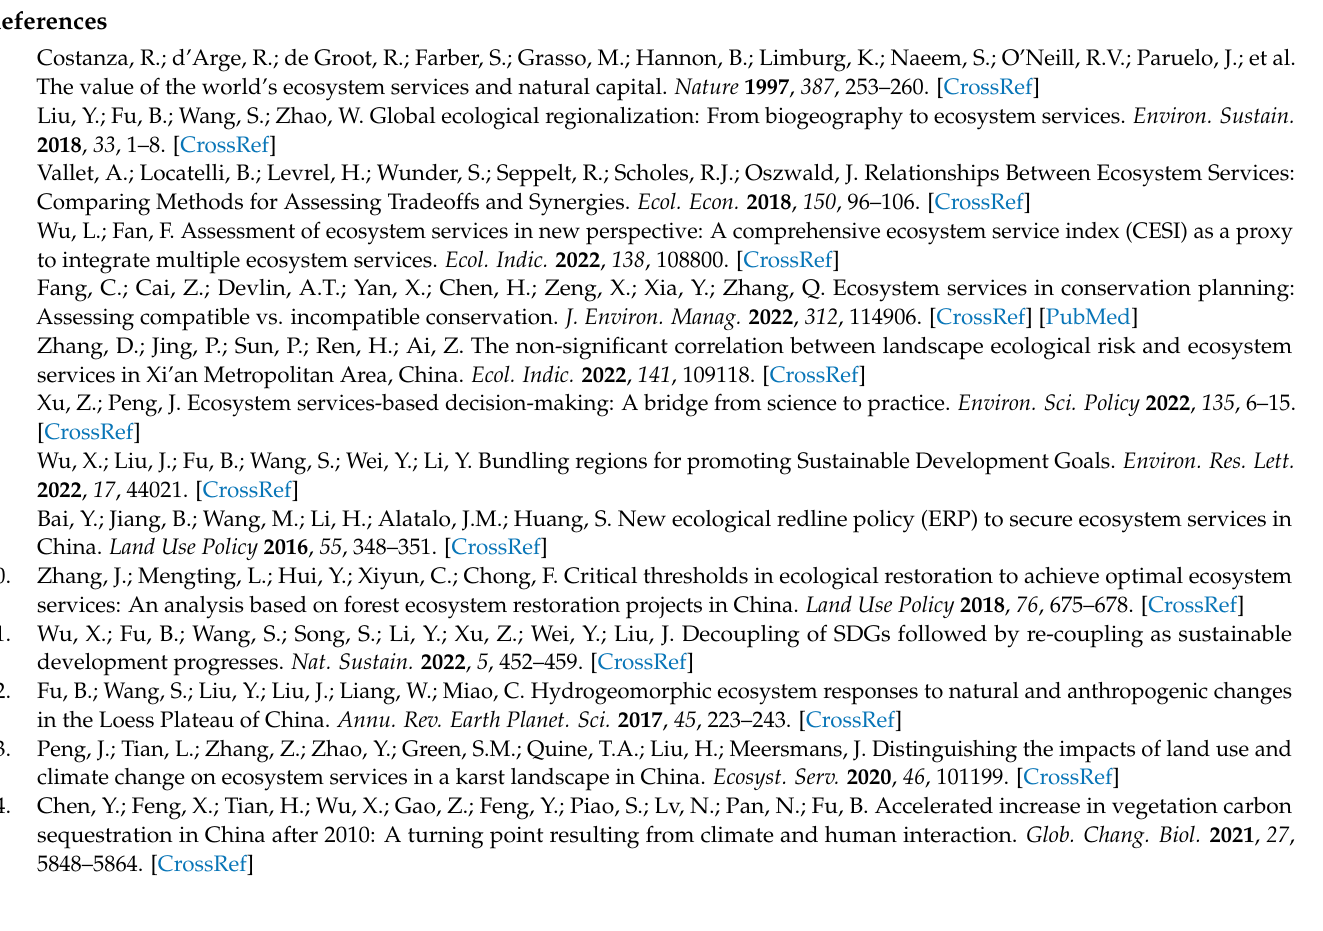
Table S3: Mean correlation (R) of ecosystem services and climate factors on the Loess Plateau; Table S4: Proportion of ecosystem services correlated with climate factors; Table S5: Three-fold fitted equations for ecosystem services and climate